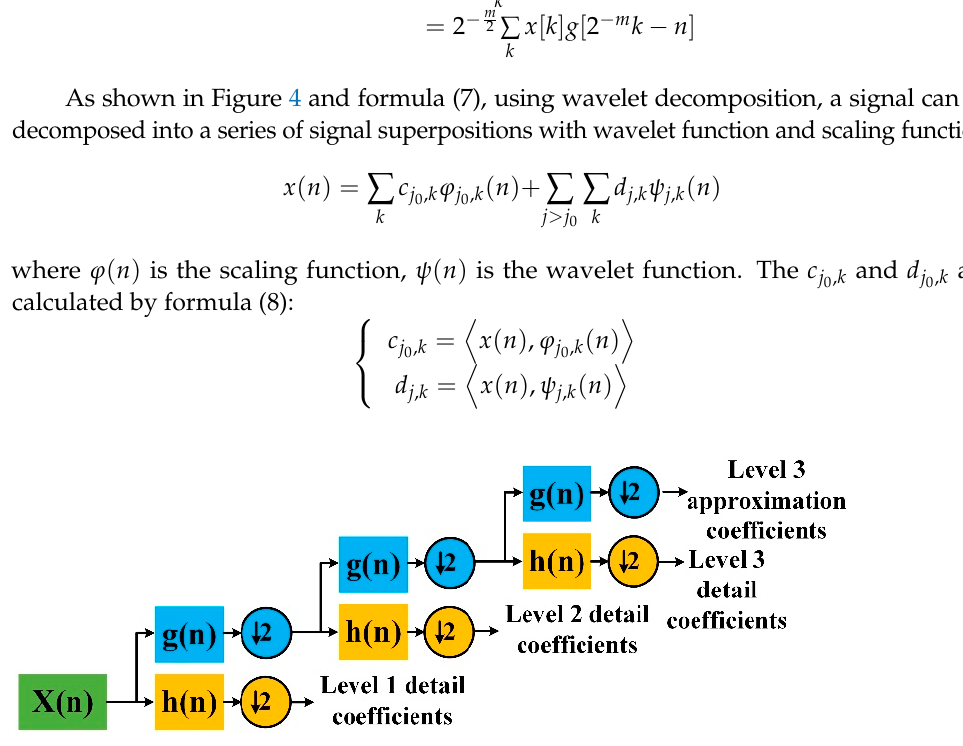
Figure 4. Diagram for discrete wavelet transform.